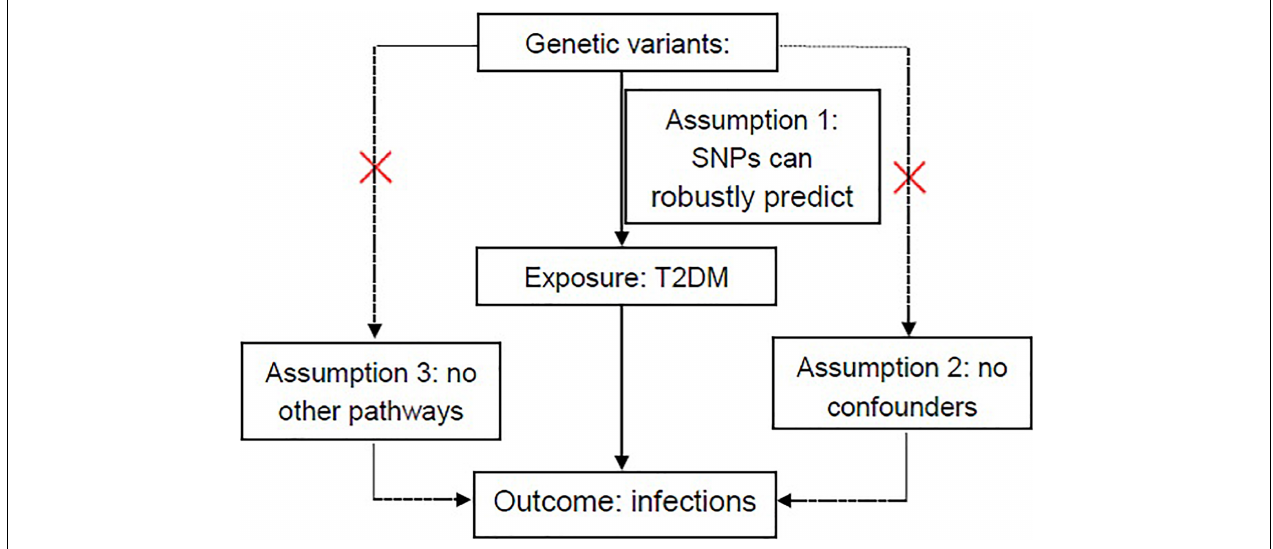
FIGURE 1 | Overview of hypotheses in MR design. Three different assumptions are represented by three paths. Assumption 1: SNPs robustly predict T2DM. Assumption 2: No potential confounders affect infections (sepsis, skin and soft tissue infections, urinary tract infections, pneumonia, and genito-urinary infection